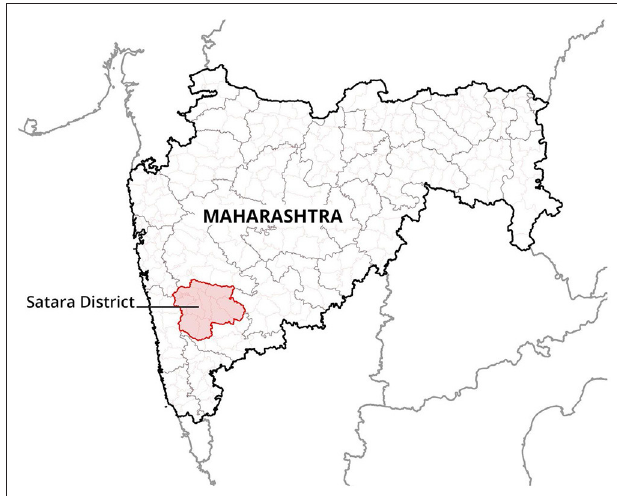
FIGURE 1 | Map of Satara (red) and surrounding districts (gray) in Maharashtra, India (Ranu